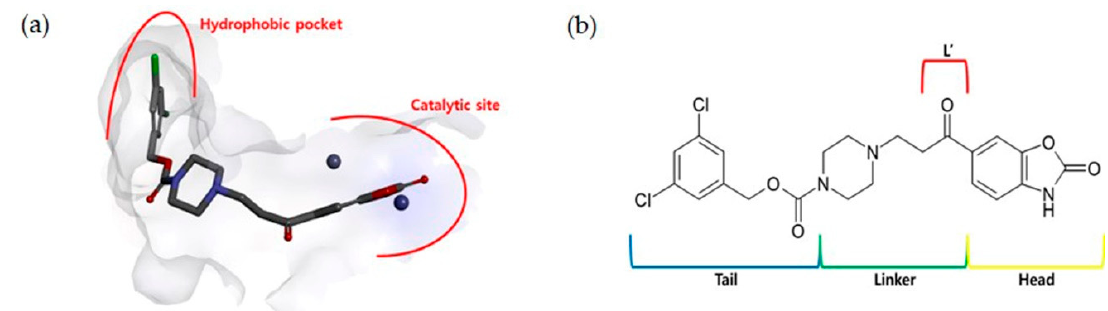
Figure 1. ( a ) A simplified schematic binding mode of PF-8380 (gray stick model) inside the autotaxin (ATX) binding pocket. Two zinc atoms in the catalytic site of ATX are represented by dark blue spheres. ( b ) 2D structure of PF-8380 divided into head, linker and tail regions. The CO group of the linker region is marked with L’.